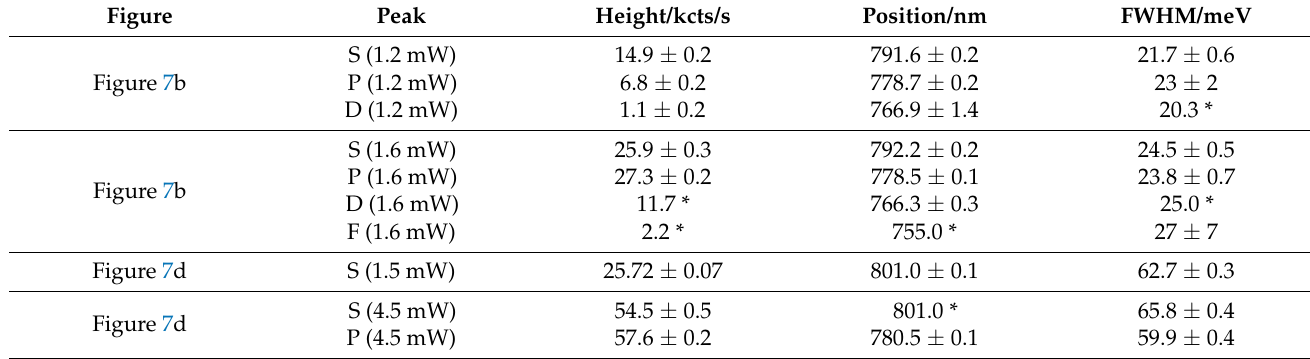
Table A2. Fit parameters for the Gaussian-fits in Figure 7, including position, peak height, and FWHM. * marks constraint fit